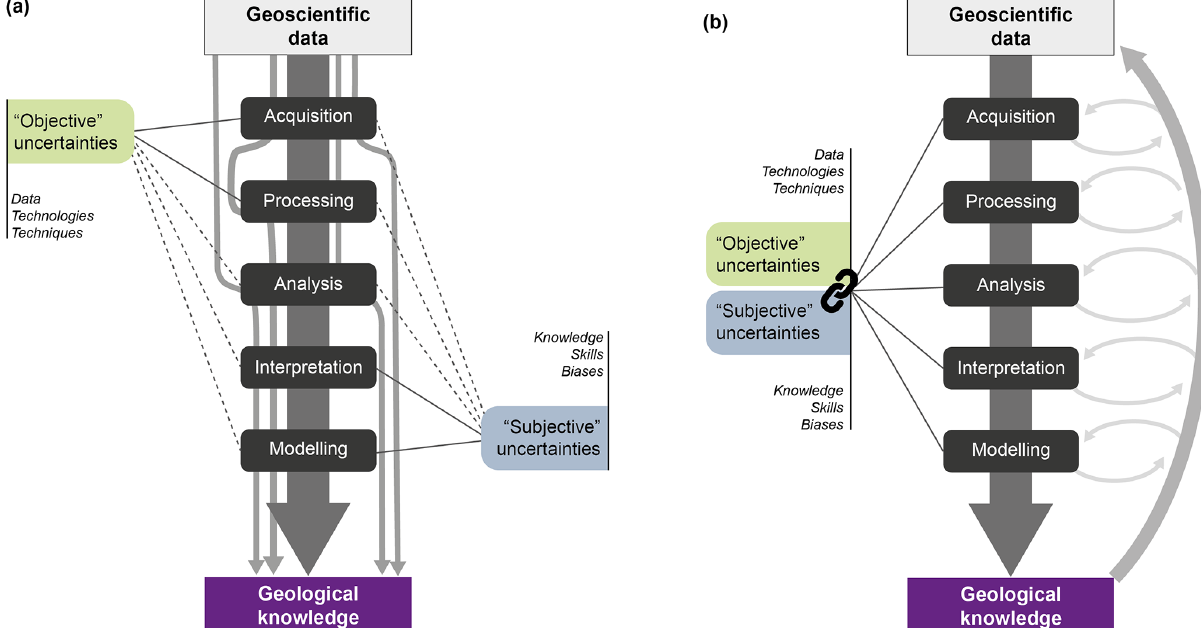
Figure 2. The process for generating geological knowledge requires the acquisition, processing, analysis and interpretation of geoscientific data. All of these stages are susceptible to objective (i.e. data-/technique-related) and subjective (i.e. person-related) uncertainty at different levels. (a) “Traditional” and (b) revised understanding of the sources of uncertainty within the process of knowledge generation, as discussed in the